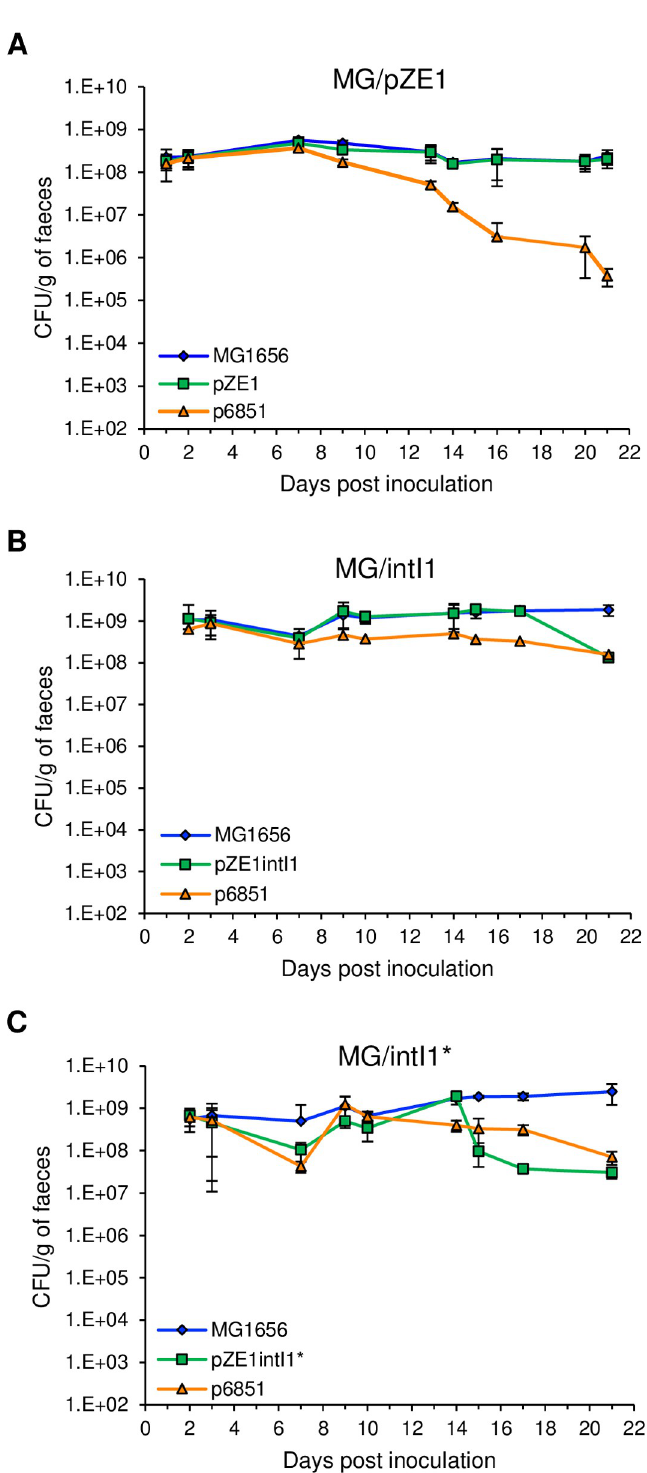
Fig 1. Bacterial colonization and plasmid stability in the mouse gut. On day 0, three groups of germ-free mice were inoculated with 10 8 CFU of MG/pZE1 control strain (carrying p6851 and pZE1 that did not carry the intI1 gene, n = 4) (A) , MG/intI1 strain (carrying p6851 and pZE1intI1 allowing the expression of intI1 SOS-regulated, n = 4) (B) or MG/ intI1 � strain (carrying p6851 and pZE1intI1 � allowing the constitutive expression of intI1 , n = 3) (C) . Bacterial colonization in the mouse gut was monitored by counting the CFU/g of faeces on non-selective medium (MG1656).